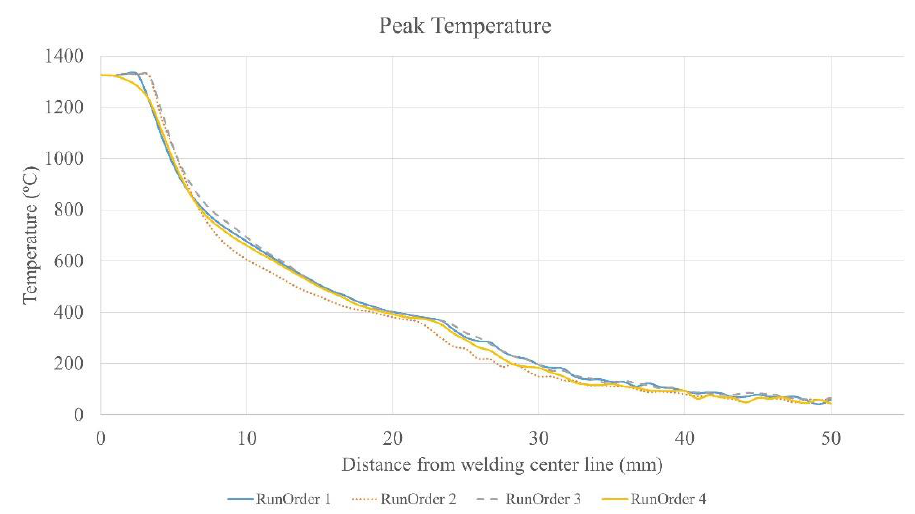
Figure 13. Peak temperature by the distance of the workpiece.